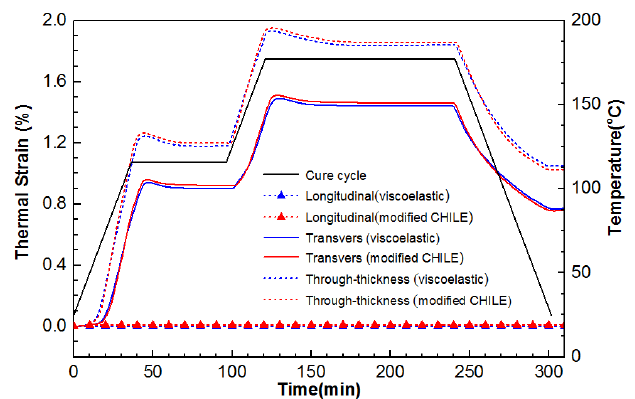
Figure 7. Comparison of thermal strain in various orientations at the point (5.08, 0, 1.27) from the modified CHILE and viscoelastic models.